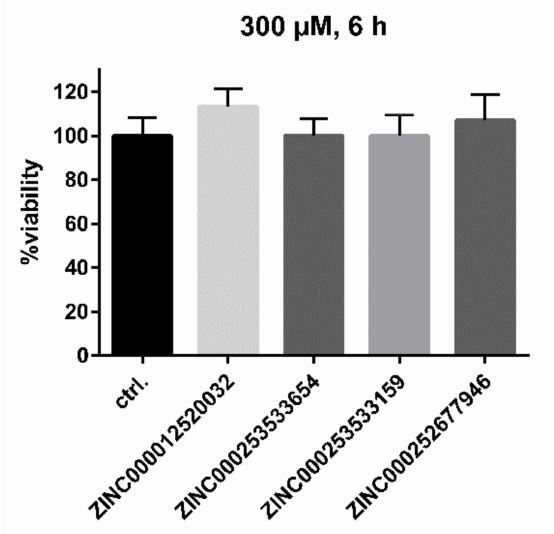
Figure 9. Cytotoxicity studies in NTCP-HepG2 cells. An MTT cytotoxicity assay was performed with the indicated compounds at 5 µ M, 50 µ M, 150 µ M, and 300 µ M inhibitor concentrations, incubated over a time span of 6 h at 37 ◦ C. Solvent control was set to 100%. Data represent means ± SD of two independent experiments, each with triplicate determinations (n = 6). Even at the highest concentrations, no cytotoxic effects could be